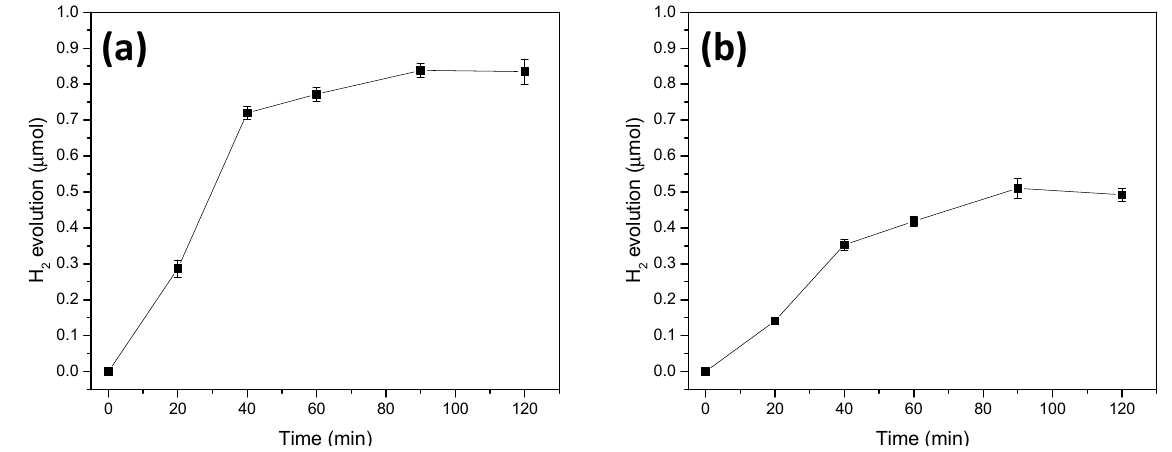
Figure 9. Hydrogen evolution data for the FeFeOH photocatalytic system at pH 5.0 with neutral density filters that transmitted 60% (0.2 mm thickness) ( a ) and 30% (0.5 mm thickness) ( b ) of the initial light. The light-driven hydrogen evolution catalyzed by FeFeOH at different concentra- tions while maintaining the standard conditions of the photosensitizer and the electron donor at pH = 5.0 for 2 h is illustrated in Figure 10a. The results indicated that the overall